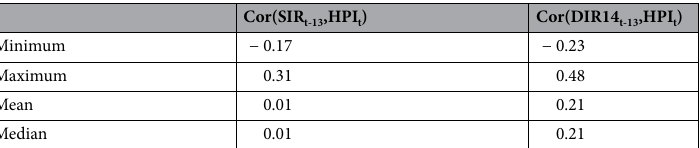
Table 3. Minimum, maximum, mean and median Pearson correlation coefficient with a 14-day lag between SIR and HPI, and DIR14 and HPI of 278 mainland Portuguese municipalities. As these correlation factors are calculated with 350 observations per municipality, a coefficient is statistically different from zero, for a 95% confidence level, if it its above(below) ± 0.1.